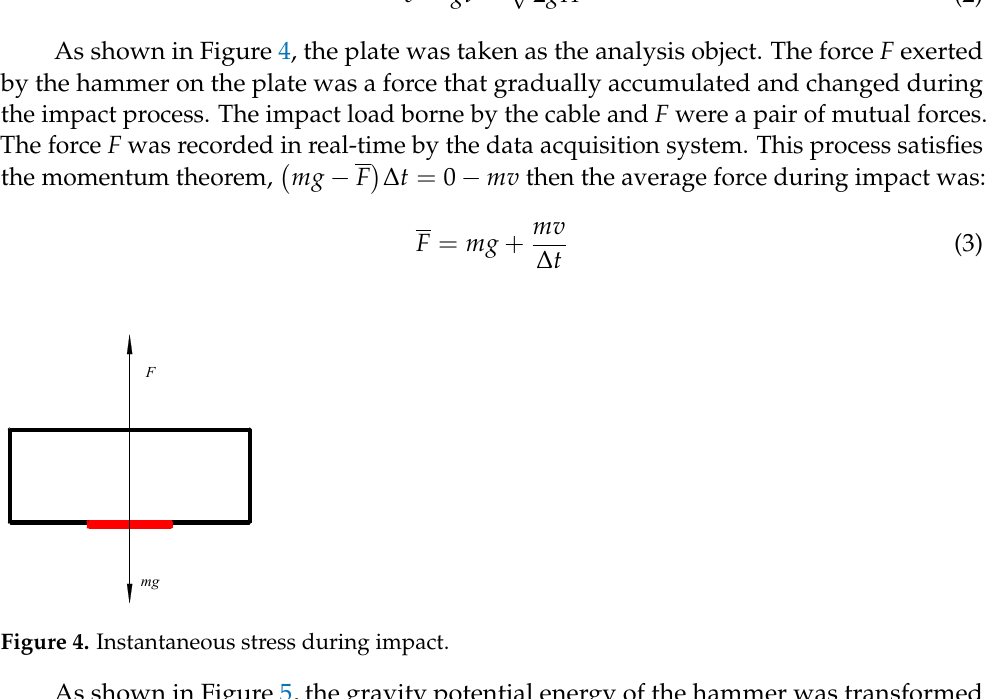
Figure 3. The energy storage stage of hammer lifted.